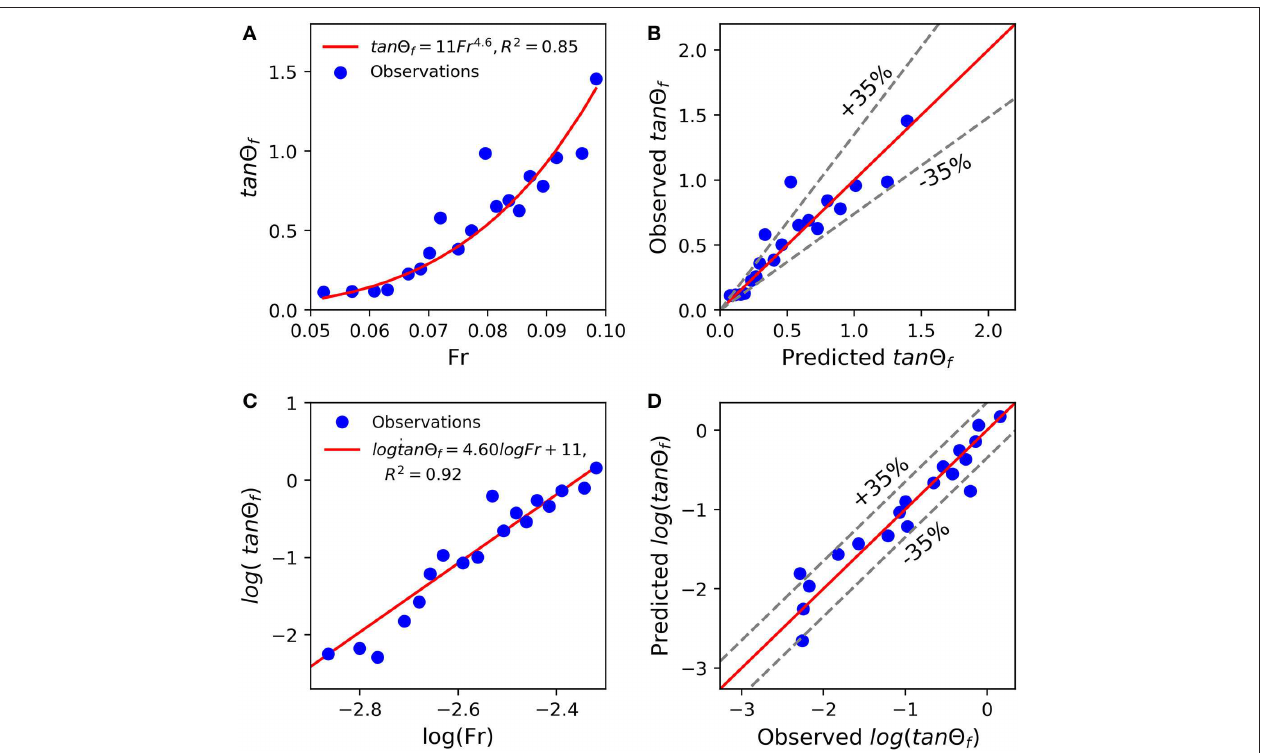
FIGURE 5 | Experiment A, (A) Power-law fit (B) Predicted vs. Observed values based on power law fit (C) log-log fit (D) Predicted vs. observed values based on log-log